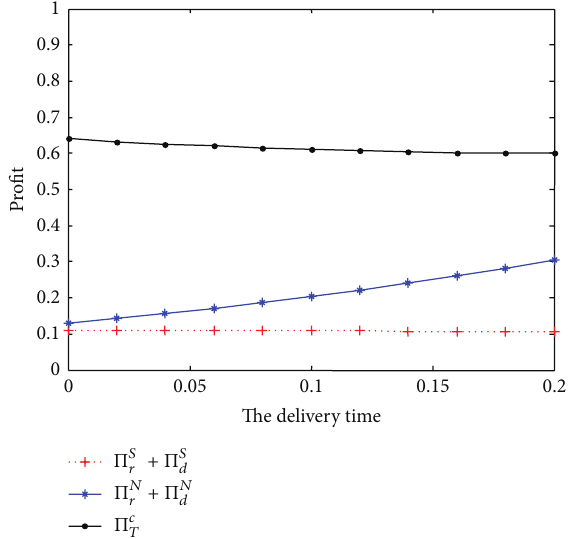
Figure 7: Total profits of three modes with respect to the delivery